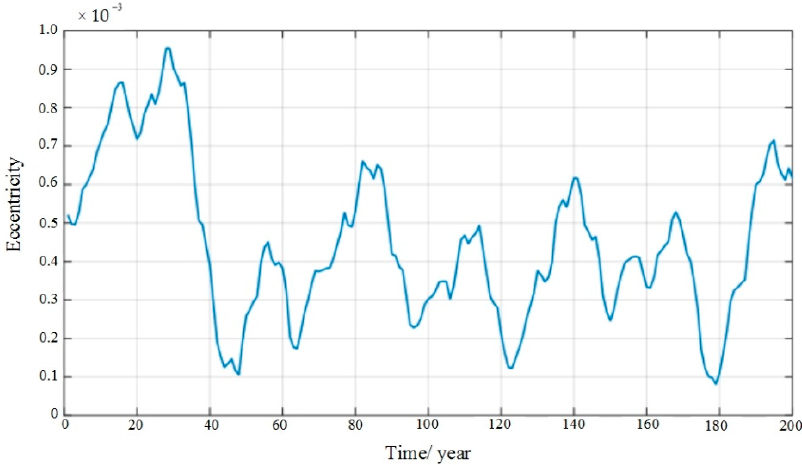
Figure 21. Variations in the eccentricity of the optimal disposal orbit.